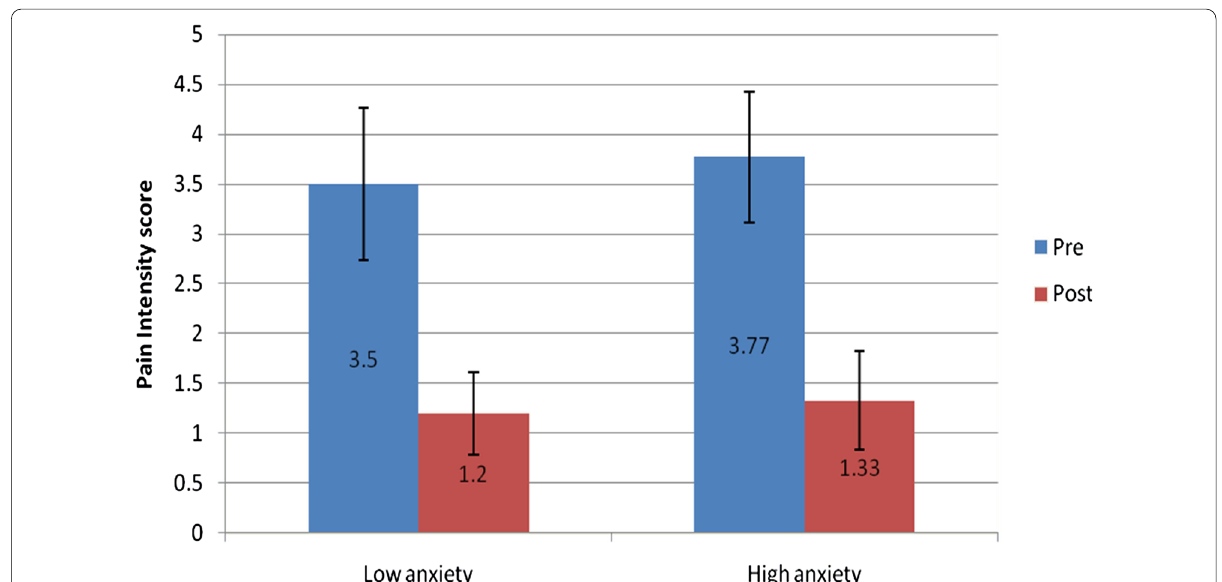
Fig. 4 Bar diagram depicting the preoperative and postoperative changes in mean value of anxiety and pain score and found that with the reduction in pain, anxiety also subsided